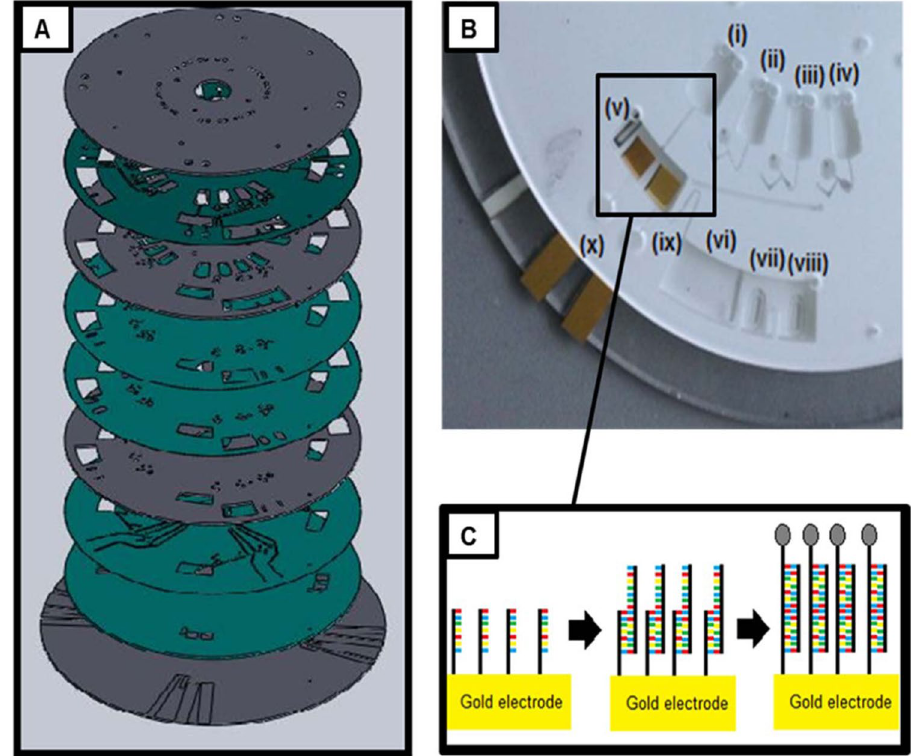
Figure 1. ( A ) Detailed view of disc assembly. The grey layers are PMMA, the green layers are PSA. ( B ) Image of fully assembled disc with integrated electrodes (cropped to view one section). Chamber (i–iv) are preloaded with (i) target miRNA strands, (ii) PBS wash step, (iii) PtNP labelled probe miRNA strands, (iv) PBS wash step/ electrolyte. Chamber (v) is the electrode chamber with ITO reference, gold working electrode and gold counter electrode. Chamber (vi) is the waste chamber, with an overflow system implemented at (vii) and (vii); these contain DF tabs. (ix) shows the siphon between the electrode chamber and the waste chamber. Labelled at (x) are the vents for the electrode chamber. ( C ) Hybridisation of miRNA strands on surface of working electrode inside chamber